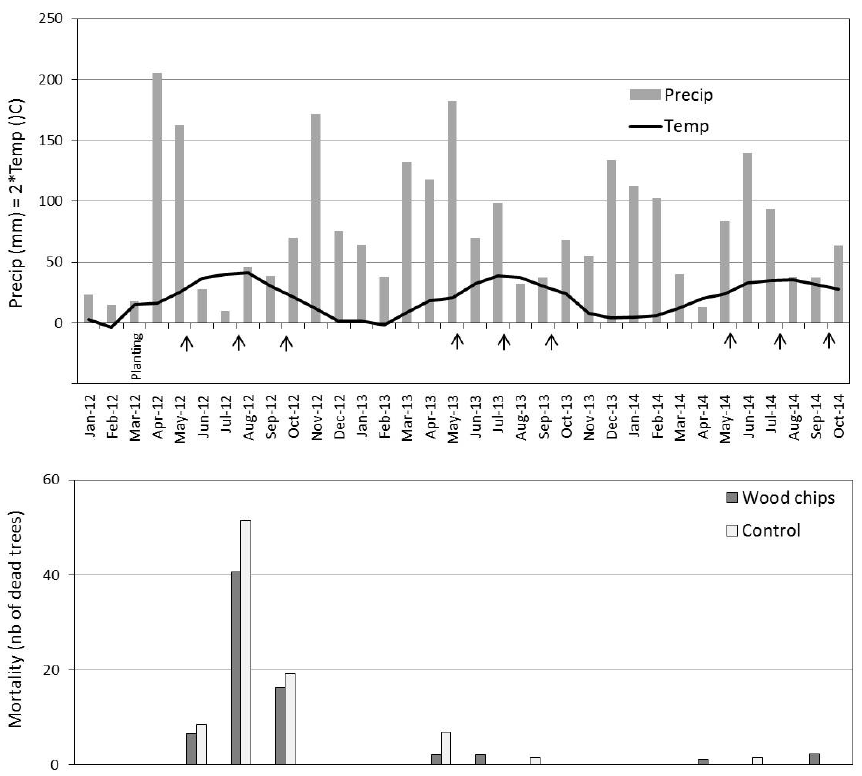
Figure 4. Mortality rate of seedlings (bottom: number of dead trees observed from the next assessment) and climatic parameters during the three growing seasons (ombrothermic diagram with monthly rainfall (mm) = 2 × monthly temperature, ◦ C). Black arrows indicate the observation dates. Mortality rates were calculated from dead plants per stage referred to the live plants at the previous